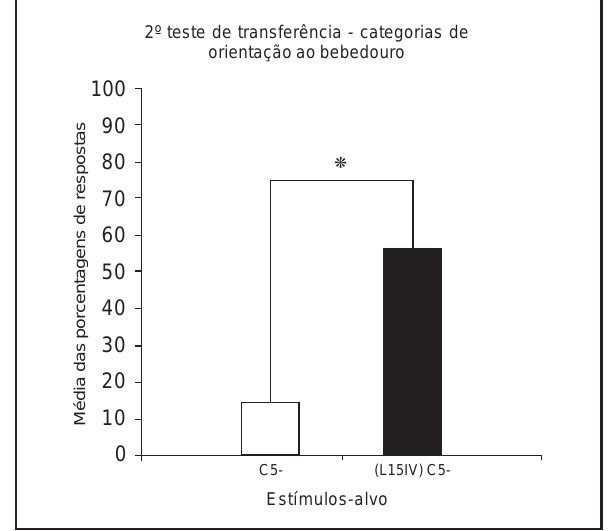
Figura 5. Médias das porcentagens de resposta das categorias agrupadas de orientação ao bebedouro ( head-jerk +lamber e\ou farejar o bebedouro) nas práticas L15 IV C5- e C5- no 2º teste de transferência. L= luz; C= Clique; IV= intervalo vazio. (Durante a fase de aquisição as práticas foram : L15 IV T5+; T5- ; L5 IV R15-; R15+). Diferença estatística (*).